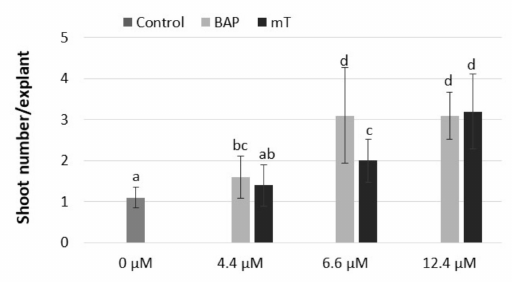
Figure 2. Effect of different cytokinin types (BAP, mT) and concentrations (4.4, 6.6, 12.4 µ M) on shoot formation of rhubarb ‘Malinowy’ after a 4-week subculture period. Sucrose concentration in the medium was 88 mM. Medium without cytokinin was the Control. Means marked with the same letter do not differ significantly ( p = 0.05) according to Duncan’s test. Table 3. Effect of cytokinin type (BAP, mT) and sucrose levels on shoot formation, fresh mass of shoots, leaf number and shoot length of rhubarb ‘Malinowy’ after a 4-week subculture period. Cytokinin